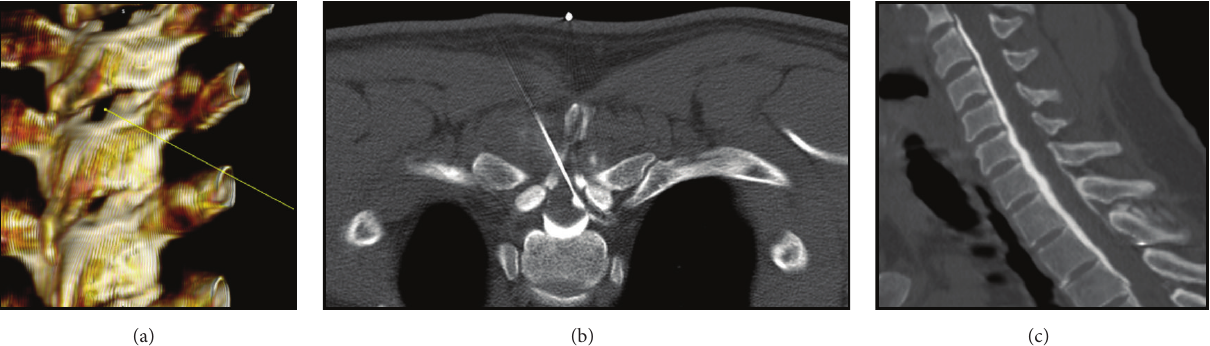
Figure 3: (a) Spine CT-scan three-dimensional simulation site for targeted EPB. (b) Targeted CT-guided EBP. (c) Spine CT-scan showing contrasted blood injected in